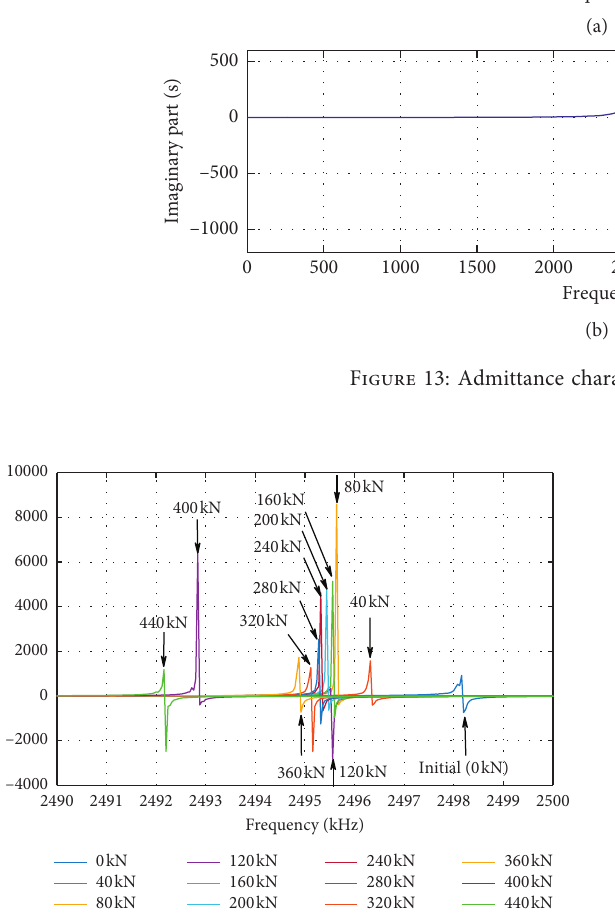
Figure 14: Admittance (imaginary part) signatures at different load conditions for column #1.